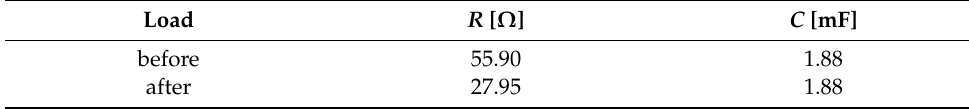
Table 16. Load parameters for steady states before and after load change.